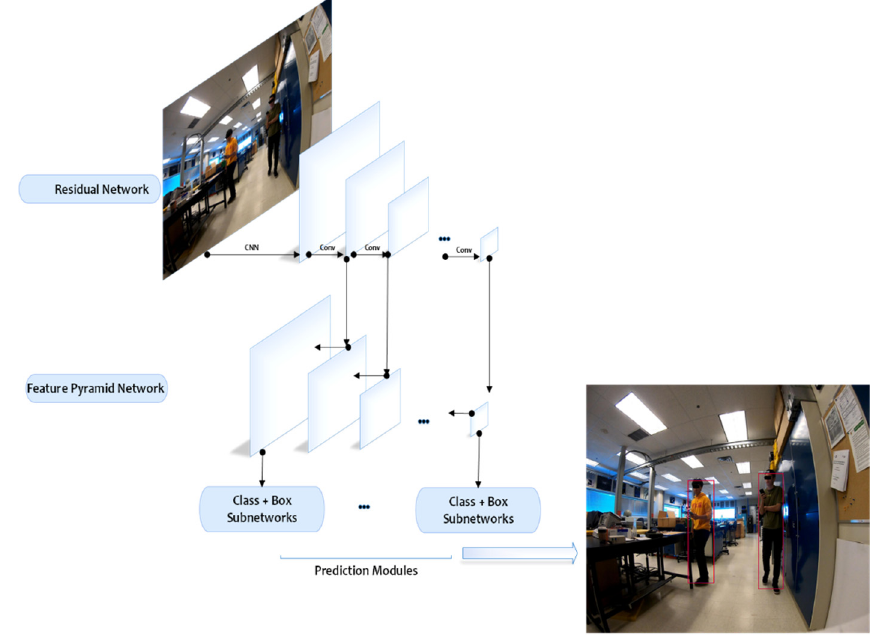
Figure 5. RetinaNet: the deep learning architecture adapted in the proposed framework.